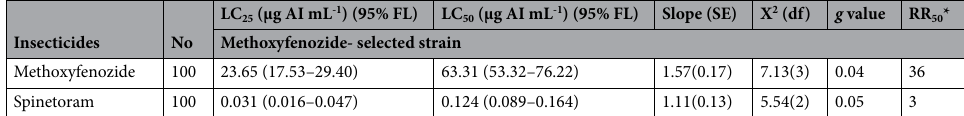
Table 3. Toxicity (LC values) and resistance ratio of methoxyfenozide and spinetoram individually to the 2nd instar larvae of a methoxyfenozide selected strain of Spodoptera littoralis after 96 h. post-treatment. No . number of larvae exposed to the insecticide, LC 25 , and LC 50 are concentrations of each insecticide, in μg (microgram) of insecticide per mL (milliliter) of water, that is required to kill 25 or 50% of the tested population, respectively. X 2 chi-square, and df Degree of freedom. g value goodness of fit, and *RR 50 (Resistance Ratio) 62 = LC 50 of tested generation/ LC 50 of parent strain.